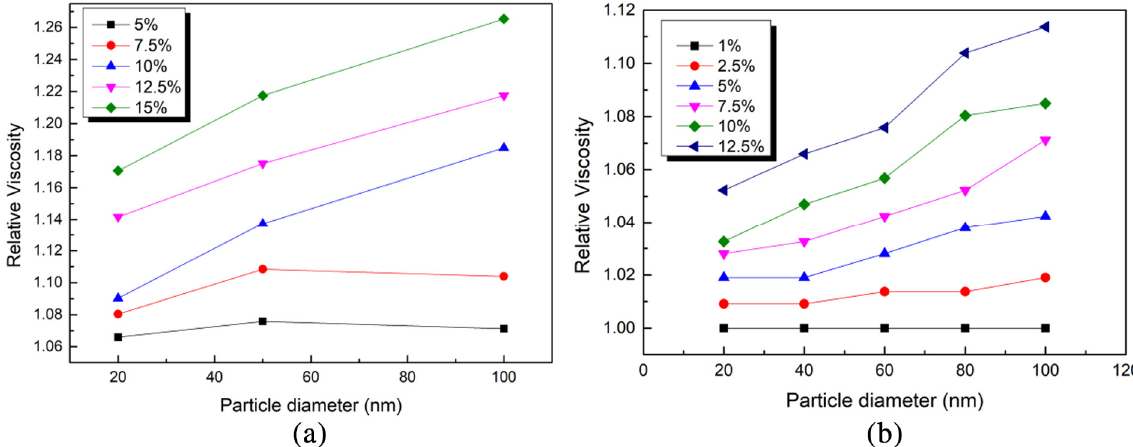
Figure 3. Effect of nanoparticle size on viscosity [56]: ( a ) Al 2 O 3 ; ( b )